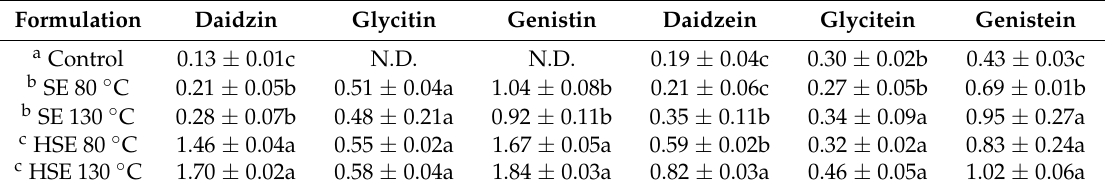
Table 5. Analysis of single isoflavone content from the soybean-polymer food composite (mg/g).